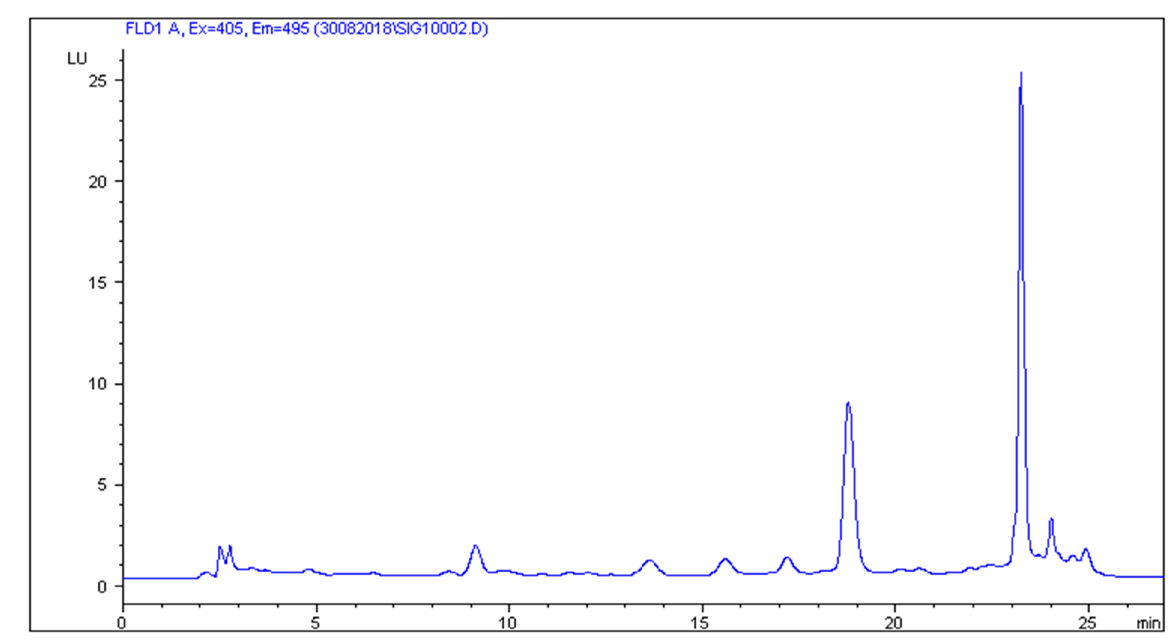
Figure 3. Blank sample of liquid manure.